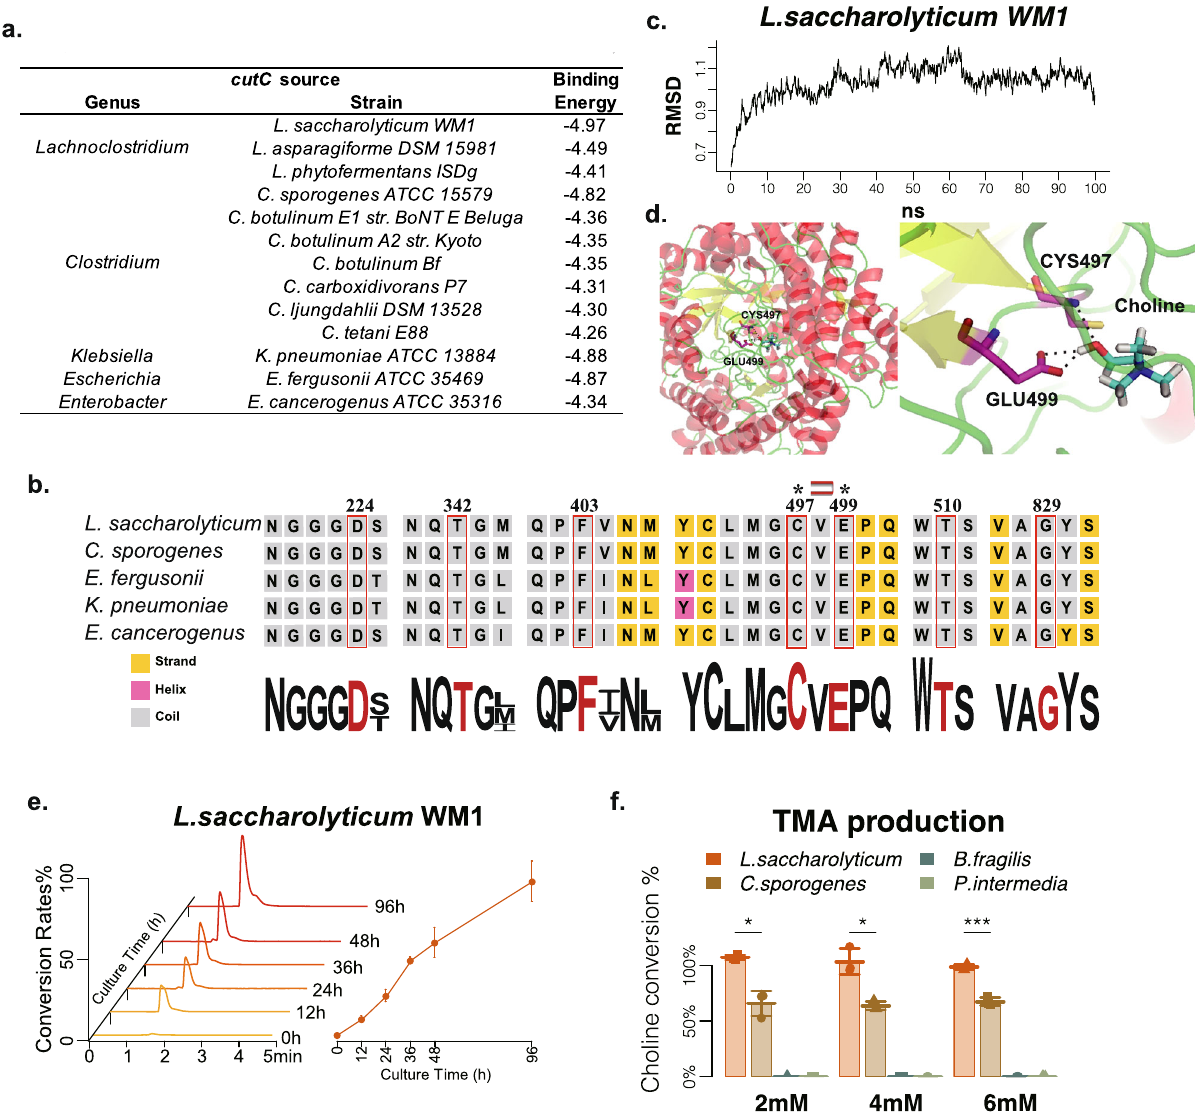
with amino acid locations indicated above. The secondary structure is represented by background color, yellow represents beta folding, and purple represents alpha spiral. The asterisks indicate hydrogen bond connections with choline, and the paper clip symbol in the middle indicate the presence of a card-issue structure. c The binding conformation complex of cutC from L. saccharolyticum and choline was stable at 100 ns dynamic equilibrium. d The AutoDock predicted binding conformation complex (from L. saccharolyticum ), within which the protein is shown as cartoon and choline as sticks. The residues that have important hydrogen-bond interactions with choline are labeled and these hydrogen bonds are represented as dashed lines. e The typical chromatogram of TMA produced by L. saccharolyticum incubated with choline at different times are shown in the left panel, and the corresponding conversion rate curve is shown in the right panel. f Barplots show the conversion rates of strains from TMA-producing genera based on various choline concentrations, 2, 4, and 6 mM ( n = 3). TMA production was assessed using LC-MS. Error bars denote the means ± s.e.m. * p < 0.05, ** p < 0.01, *** p < 0.001, differences were conducted by Mann – Whitney – Wilcoxon